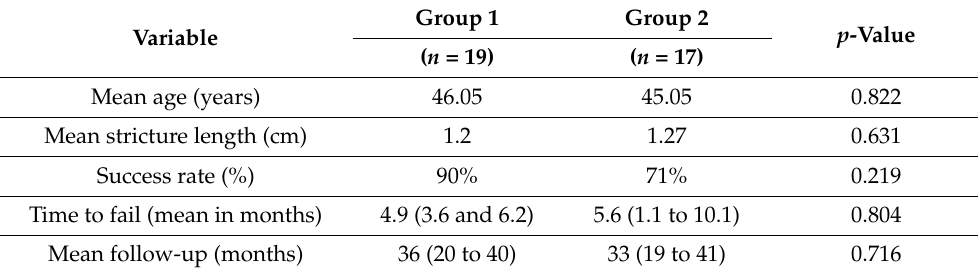
Table 1. Summary of stricture characteristics and surgical outcomes by patient group.